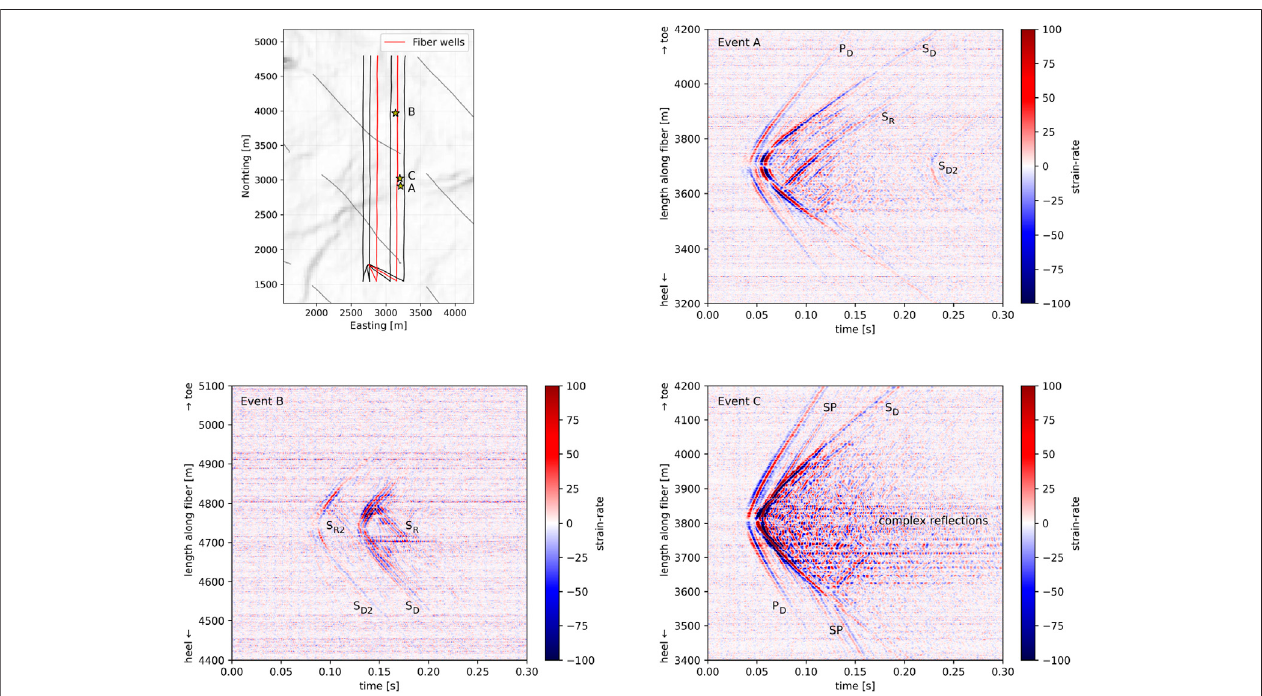
FIGURE 1 | Upper left: A map of the studied area with horizontal wells (running N-S) and their relative positions. Wells with permanently installed fi ber are shown in red. The diagonal NW-SE wells shown in gray are previously drilled production wells in the Niobrara. The yellow stars represent examples of strong microseismic events (A,B,C).TheseismiccoherencymapinthebackgroundmayindicatepotentialfaultsintheNiobraraformation.Upperrightandbottom:Examplesofthreerepresentative microseismiceventswithdirectP-waves(P D ),directS-waves(S D ),converted S-toP-waves(SP),andre fl ected S-waves(S R )recordedbyDASarray.TheeventsA and B are accompanied by other weaker events with very similar moveouts (S D2 , S R2 ) indicating similar location but slightly different origin time. Event C shows more complicated re fl ections after the direct